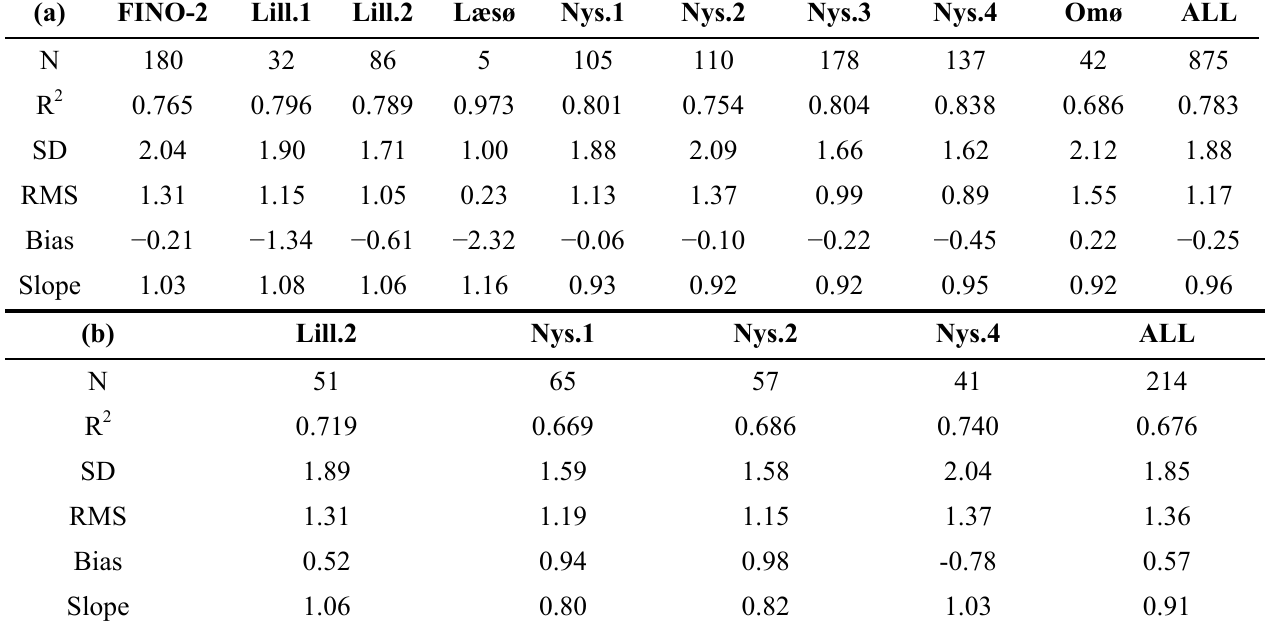
Table 4. ( a) Linear regression results for wind speed between mast data versus SAR-wind maps in free stream sectors; ( b) wake sectors. N is number of samples ( − ); R 2 is